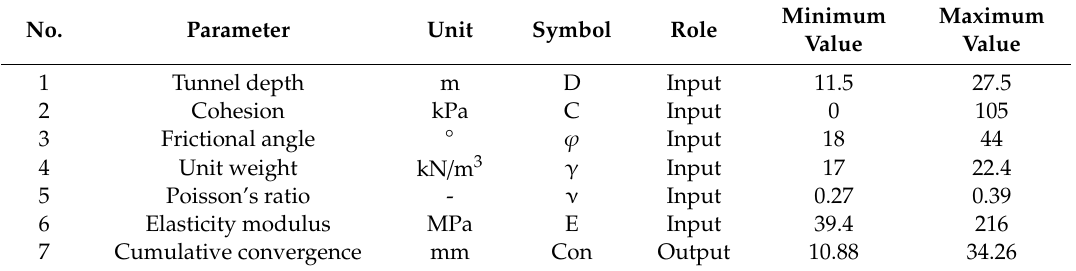
Table 3. Input parameters in convergence prediction using gene expression programming (GEP).